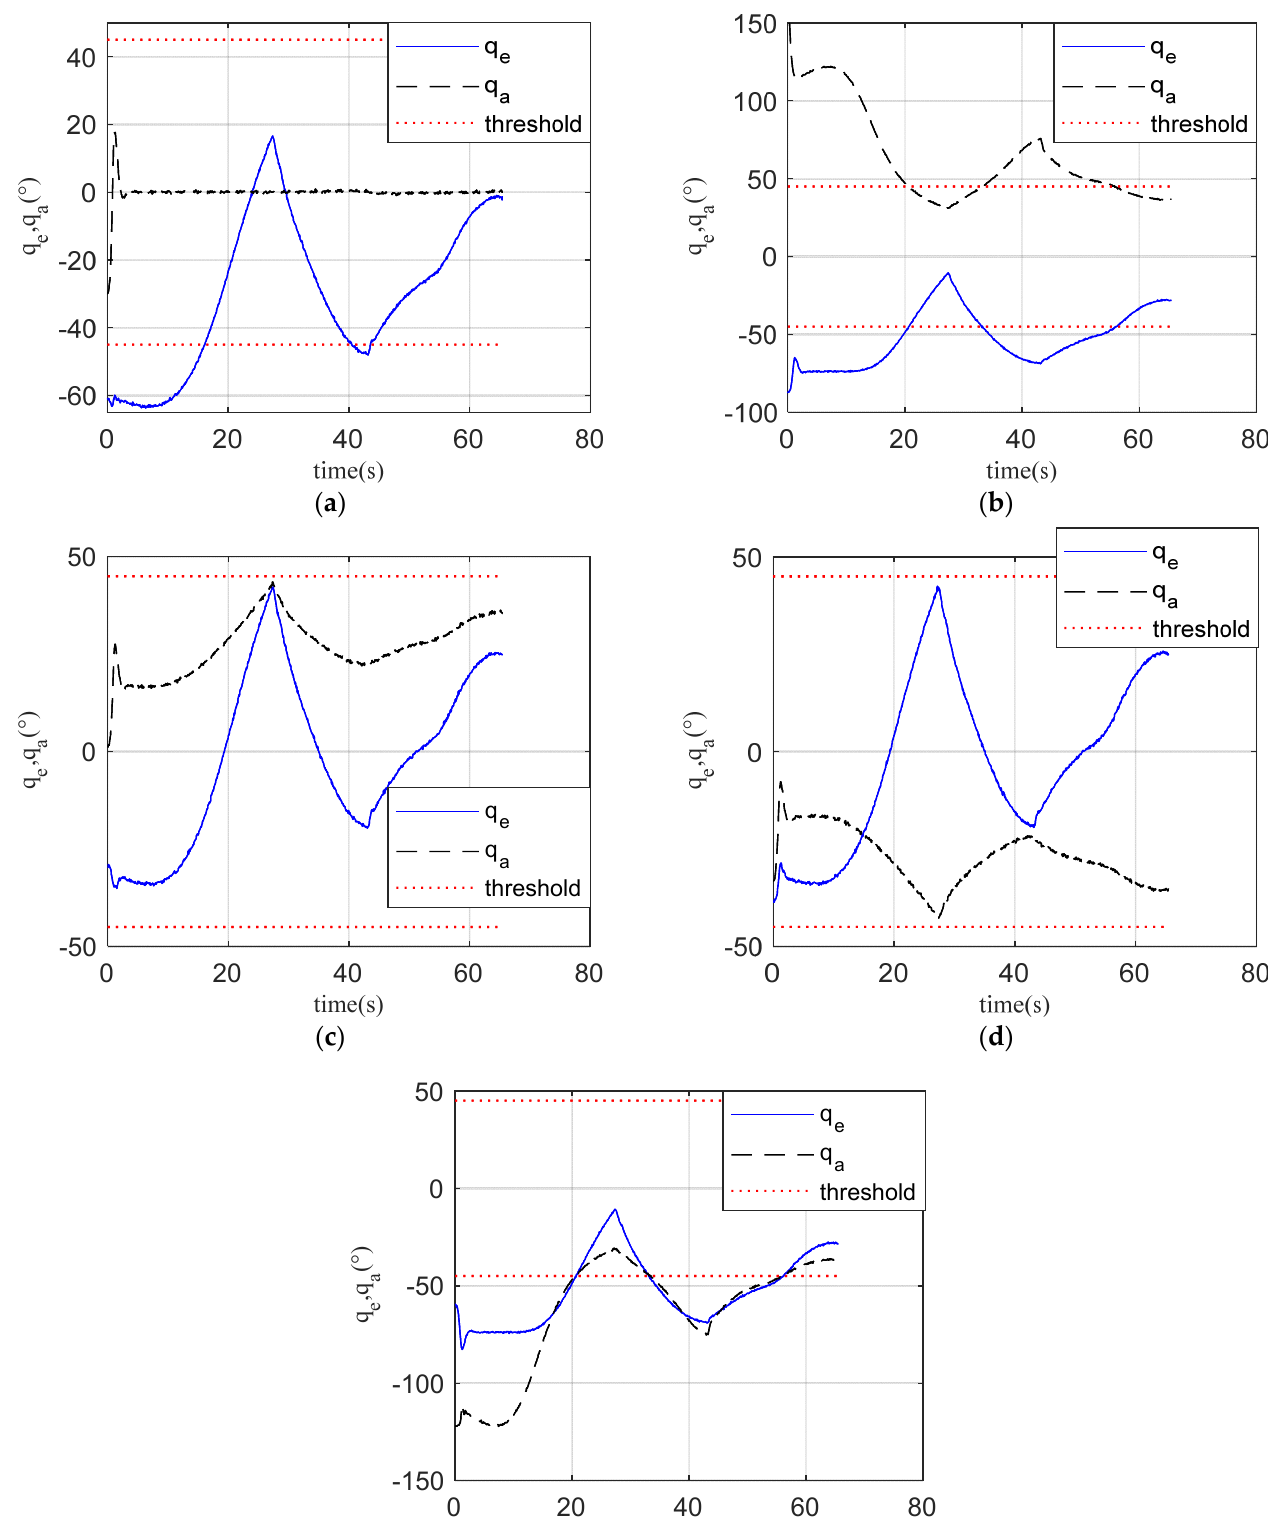
Figure 9. The result of sensors measurement. ( a ) Sensor 1. ( b ) Sensor 2. ( c ) Sensor 3. ( d ) Sensor 4. ( e ) Sensor 5. q In Figure 9, the blue curve e represents the target LOS altitude angle, and the black q represents the target LOS azimuth angle detected by the sensor. As mentioned curve a in Section 2, the FOV angle of the sensor is 45°. The red curve threshold represents the sensor FOV boundary. The target appeared within the sensor FOV range only when the